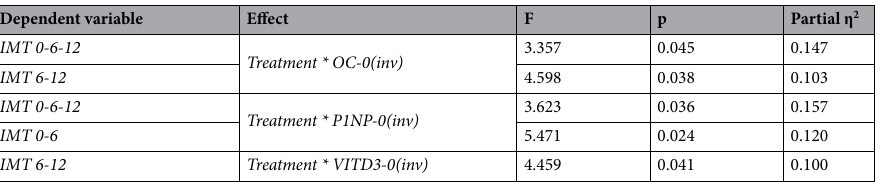
Table 4. Significant results of general linear model (GLM) repeated measures analysis of variance (RM-ANOVA) test determining the effects of treatment and other independent variables on IMT as dependent variable. GLM general linear model, IMT carotid intima-media thickness, inv inverse, OC osteocalcin, P1NP procollagen type I N-propeptide, RM-ANOVA repeated measures analysis of variance, VITD3 vitamin D3.